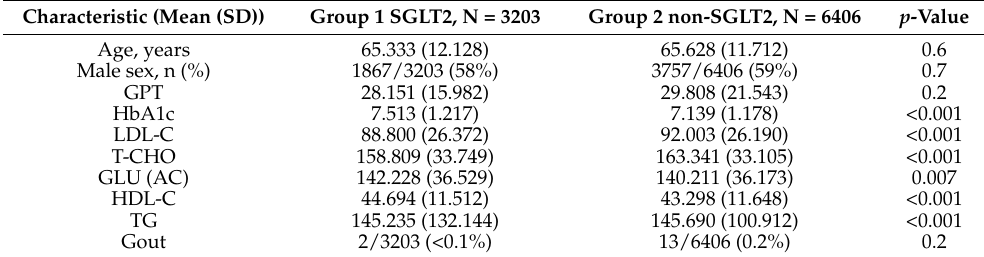
Table 1. Characteristics of the patients included in the